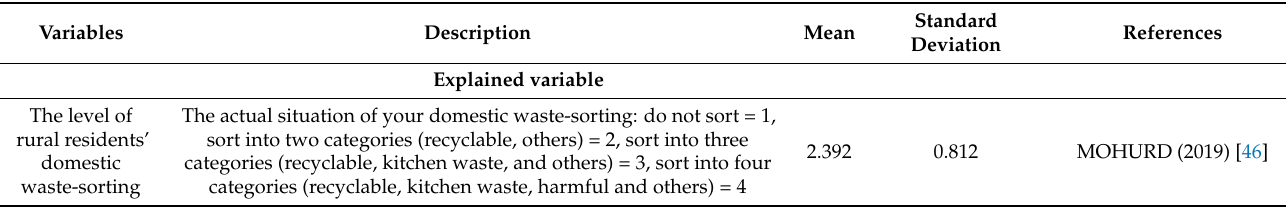
Table 1. Variables selection and statistical